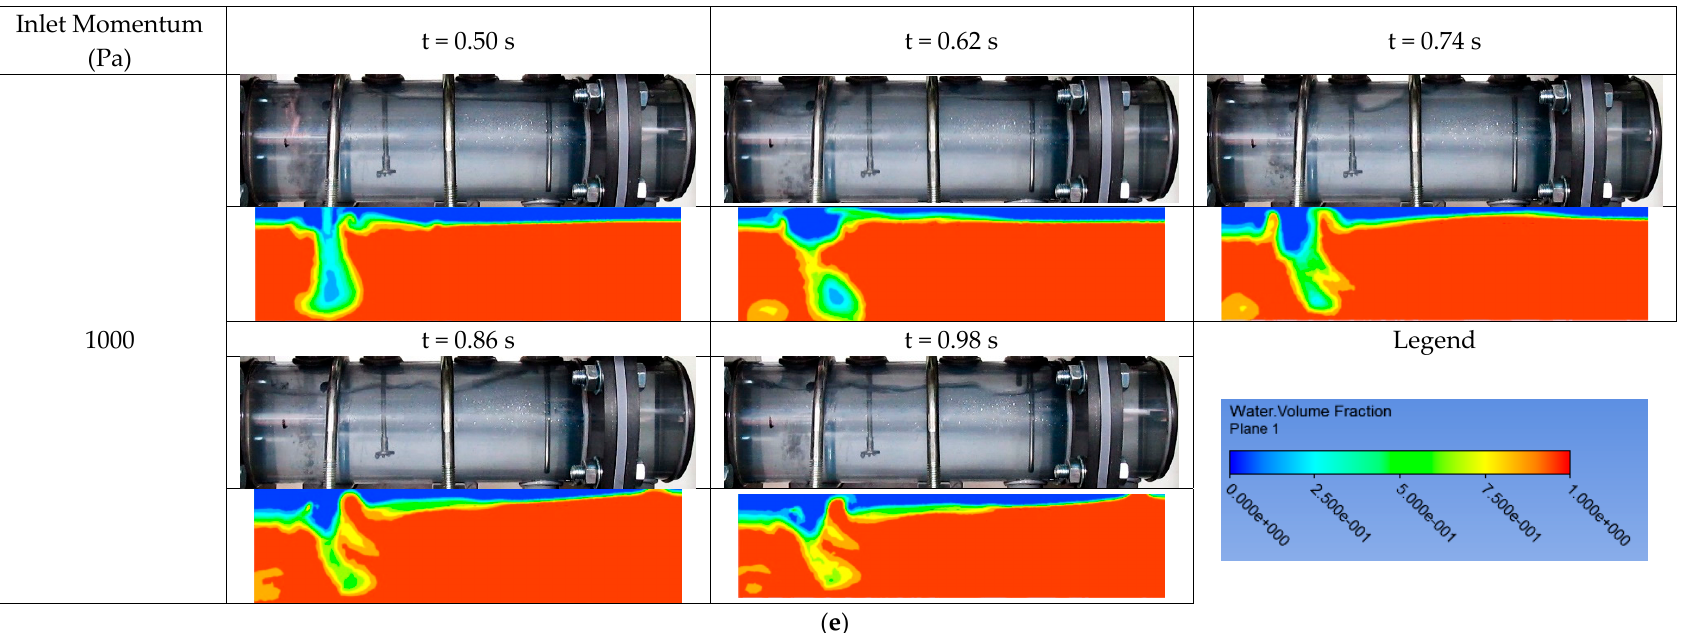
Figure 16. ( a ) Comparison of both experimental and simulated results for hydrodynamics inside the separator for an inlet momentum of 200 Pa; ( b ) Comparison of both experimental and simulated results for the hydrodynamics inside the separator for an inlet momentum of 400 Pa; ( c ) Comparison of both experimental and simulated results for the hydrodynamics inside the separator for an inlet momentum of 600 Pa; ( d ) Comparison of both experimental and simulated results for the hydrodynamics inside the separator for an inlet momentum of 800 Pa; ( e ) Comparison of both experimental and simulated results for the hydrodynamics inside the separator for an inlet momentum of 1000 Pa.